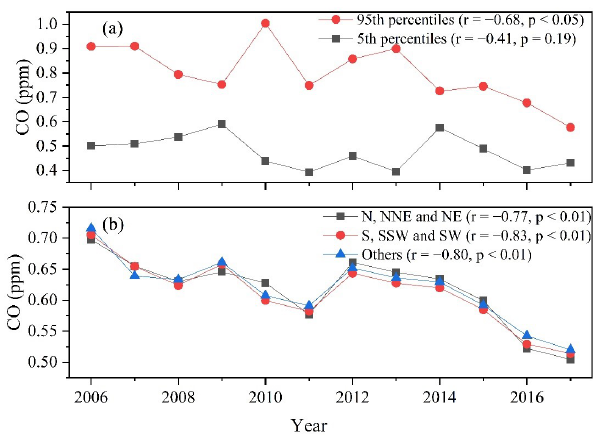
Figure 8. Trends of CO mixing ratios at the 95th and 5th percentiles and from different wind